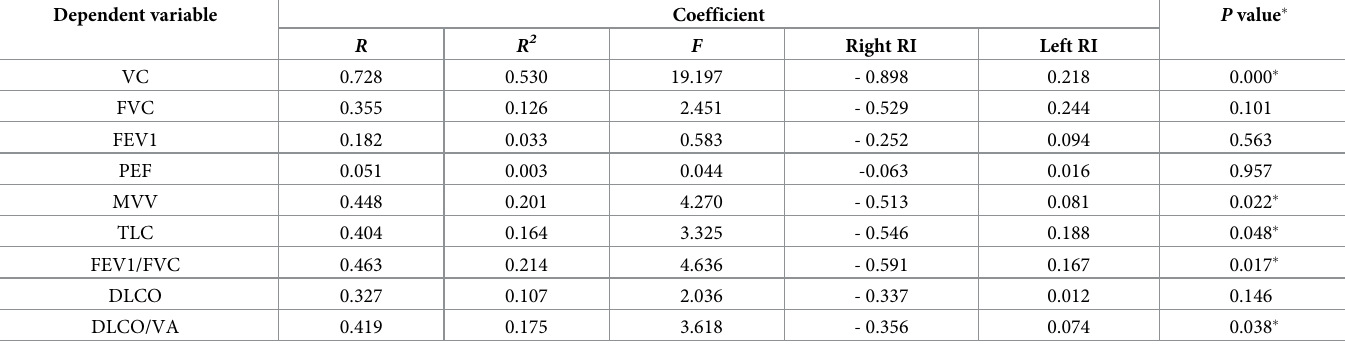
Table 5. Multiple regression analysis between pulmonary function and bilateral kidney RI in diabetes